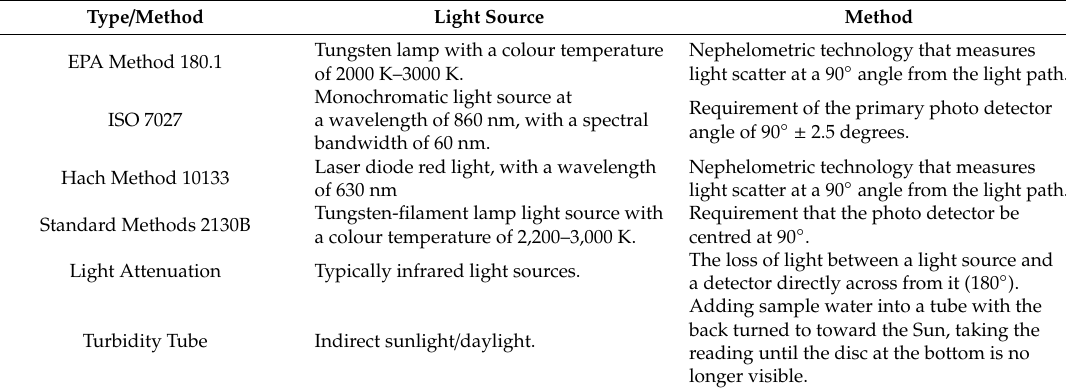
Figure 1. Different methods for measuring the light scattering effects of suspended particles. Figure 1. Di ff erent methods for measuring the light scattering e ff ects of suspended particles. Table 2. Turbidity measurement